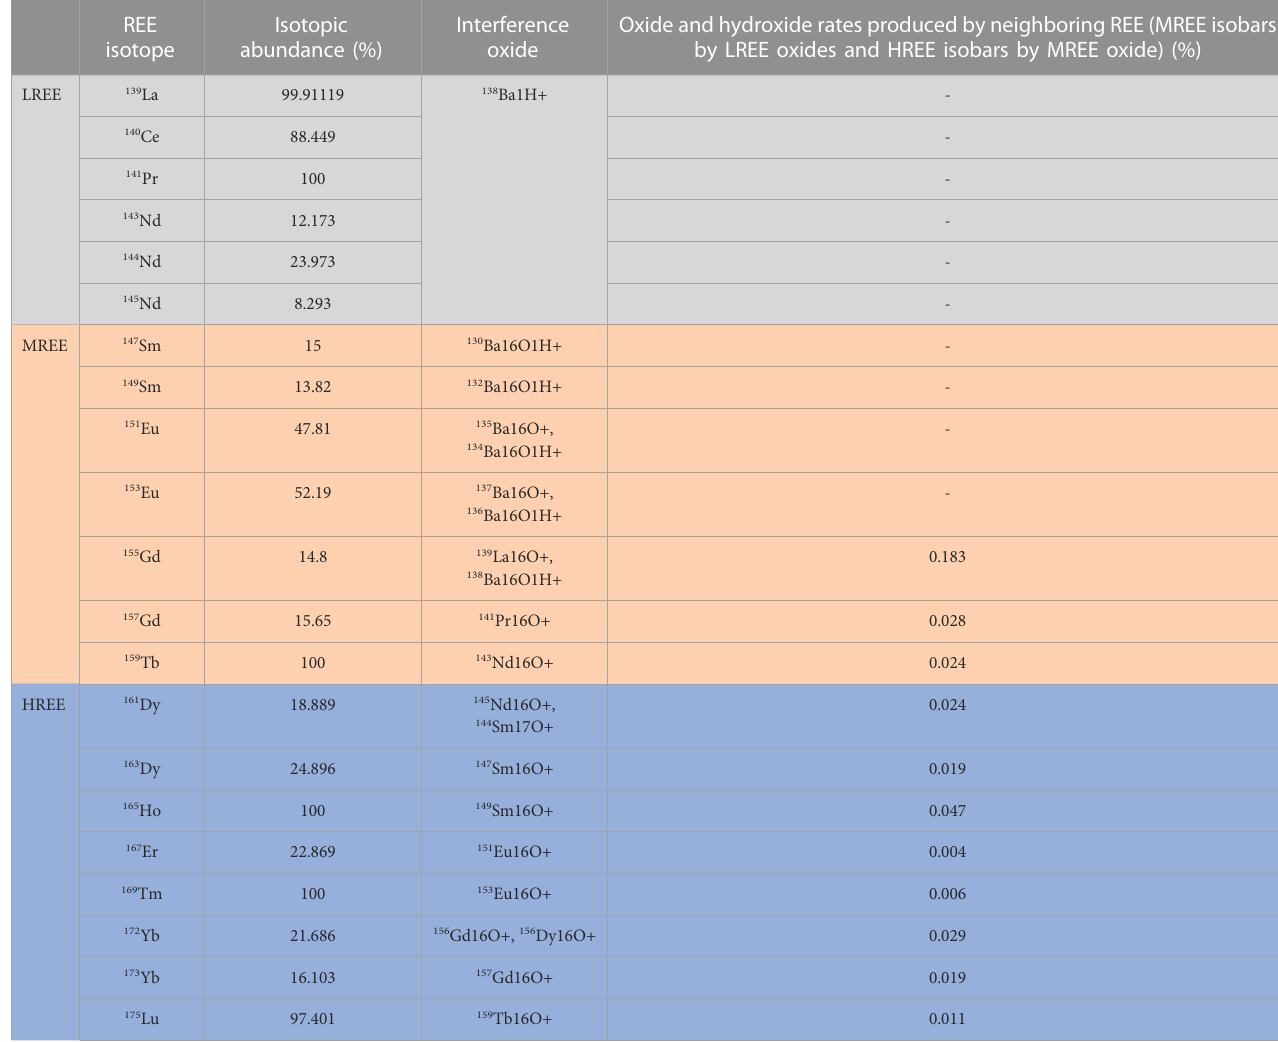
TABLE1REEisotopesusedfordeterminingconcentrationsbyusingtheMC-ICP-MSandtheirisobaricinterferenceisotopes.Thecontributionoftheoxideinterferences totheintensitysignalofeachREEgroupwasassessedbymeasuring(L,M,H)REEO+/(L,M,H)REEratiosin10 ng/mLmultielementstandardsolutions via aCetacAridus II desolvating system (Wysocka,